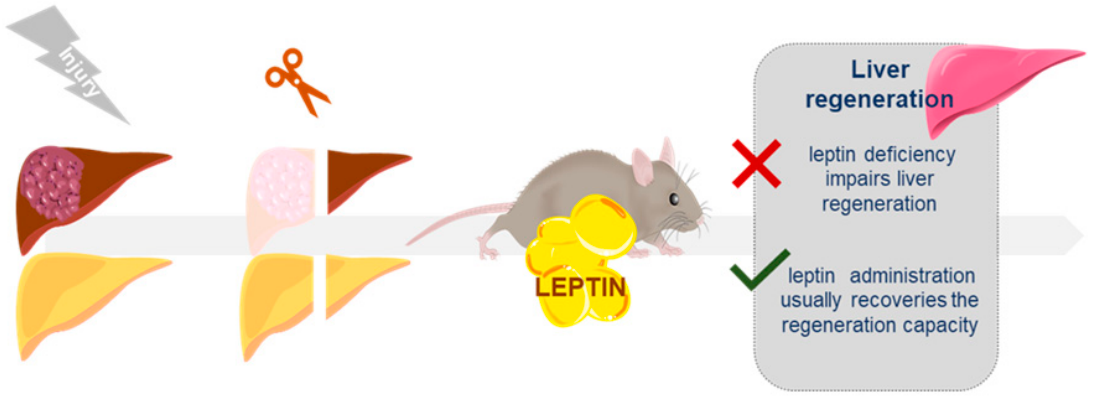
Figure 4. Schematic overview of leptin repercussion on liver regeneration.